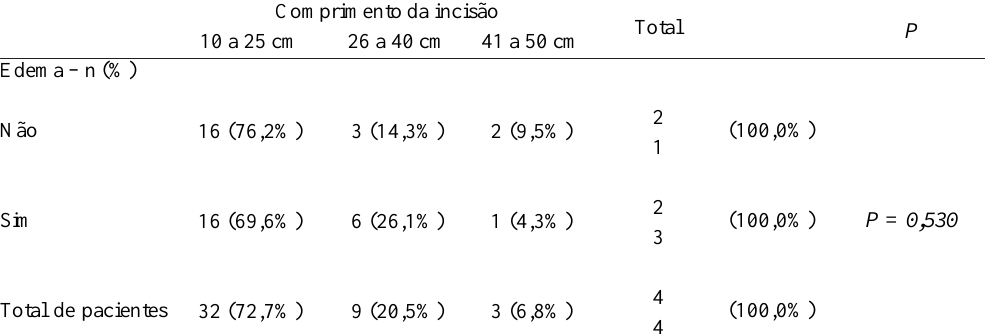
Tabela 2. Comprimento da incisão por presença de